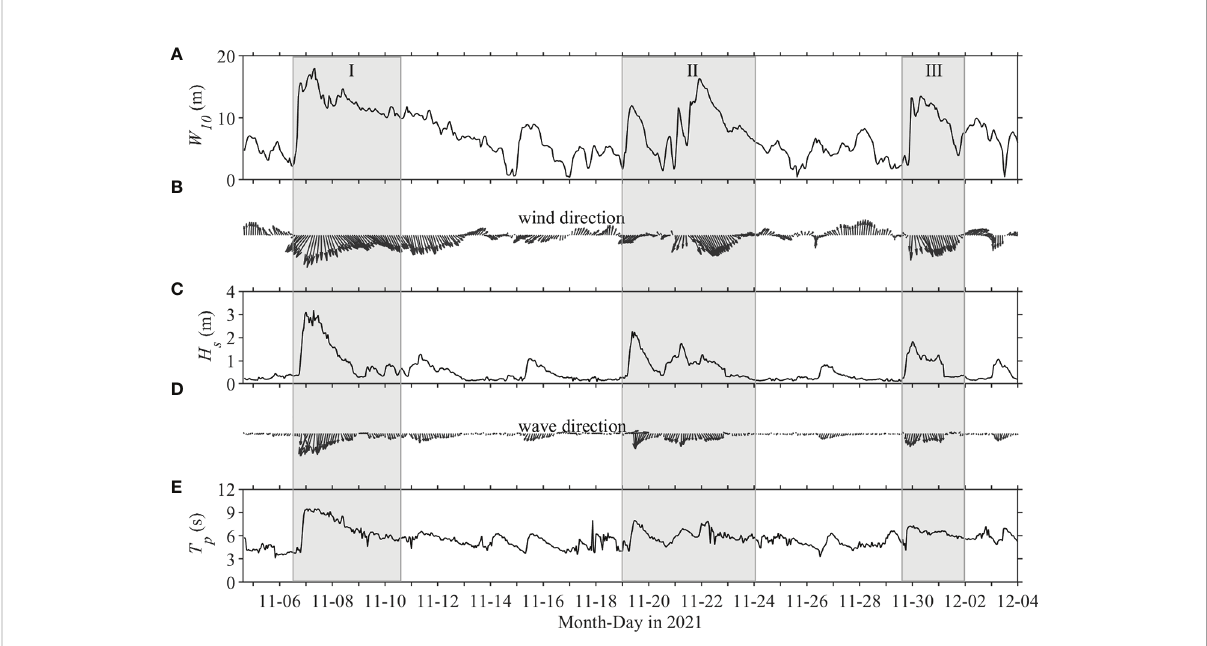
FIGURE 5 Time series of (A) wind speed at 10 m above ground surface ( W 10 ), (B) wind direction, (C) signi fi cant wave height ( Hs ), (D) peak wave direction, and (E) peak wave period ( Tp ). Gray rectangular boxes represent weather events I, II, and III, used to discuss wave processes during